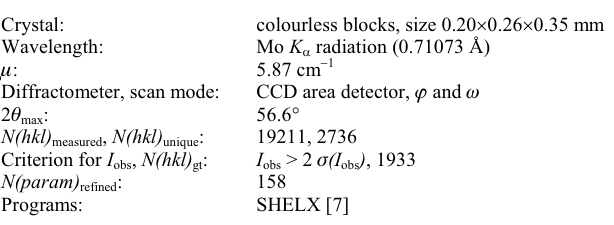
Table 1. Data collection and